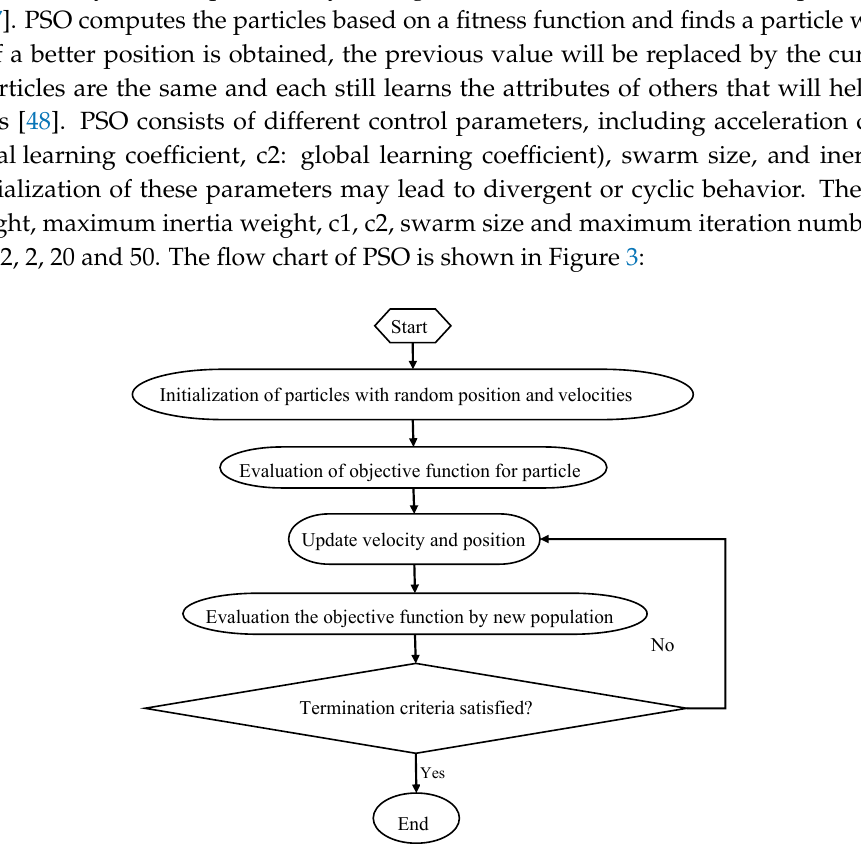
Figure 3. Schematic representation of the optimization rationale for for particle swarm optimization (PSO).